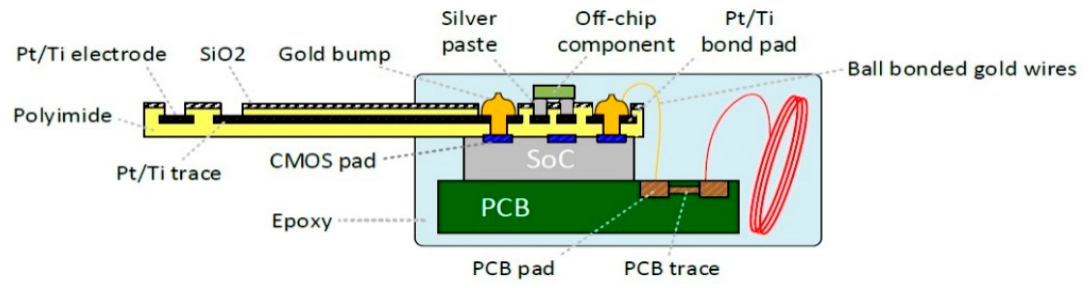
Figure 3. Illustration of heterogeneous packaging for wireless extraluminal gastrointestinal modulation device (EGMD).